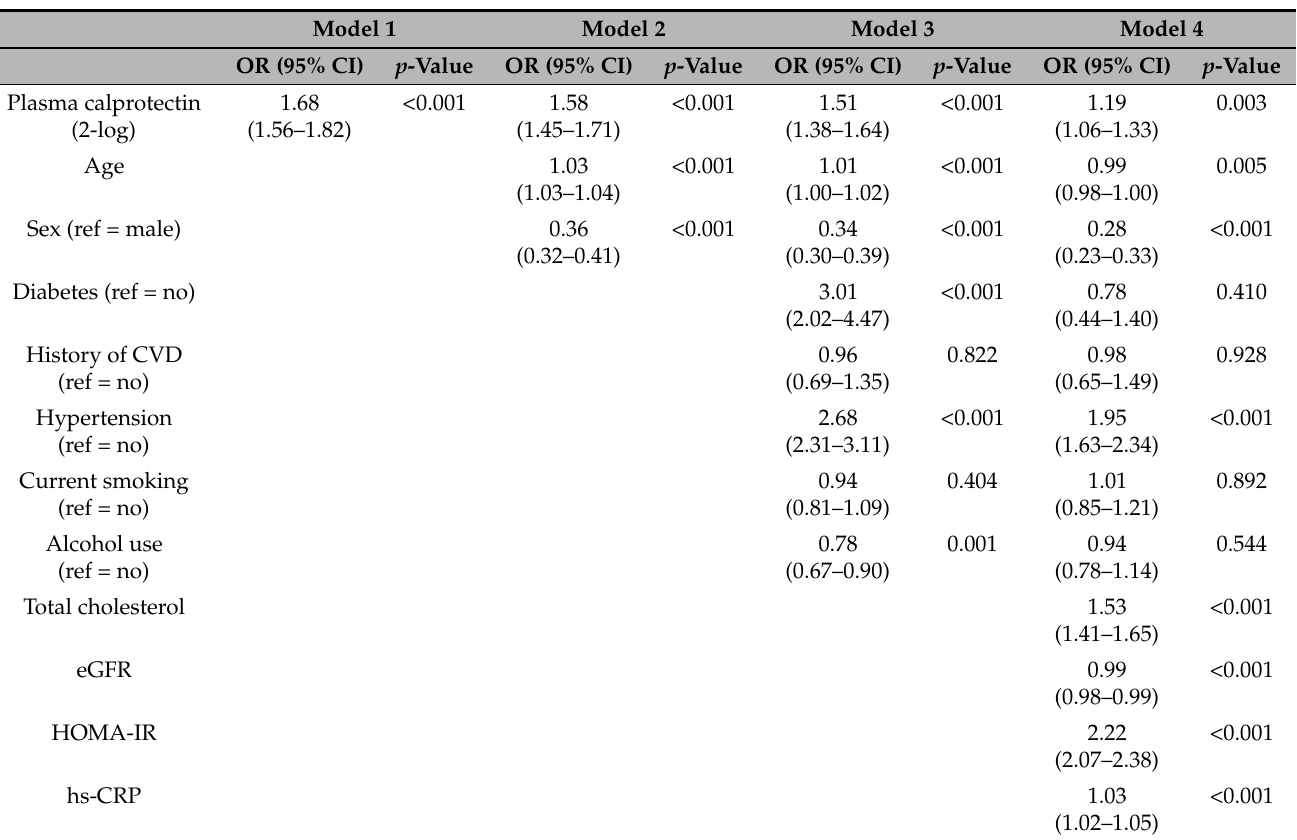
Table 2. Univariable and multivariable logistic regression analyses investigating the association between the FLI and plasma calprotectin levels ( 2